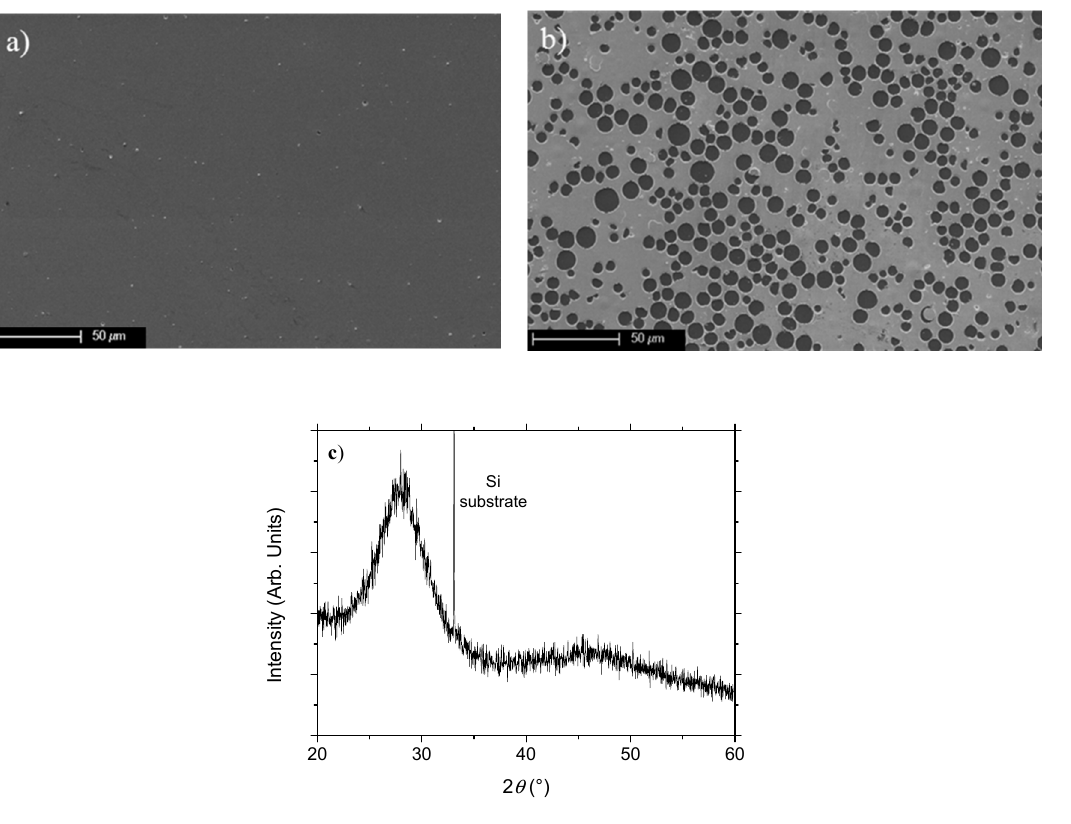
Figure 6. Surface morphology of ( a ) an as-deposited film, ( b ) after an air annealing at a temperature of 275 °C for 2 h, and ( c ) X-ray diffractogram of the film annealed at 275 °C.